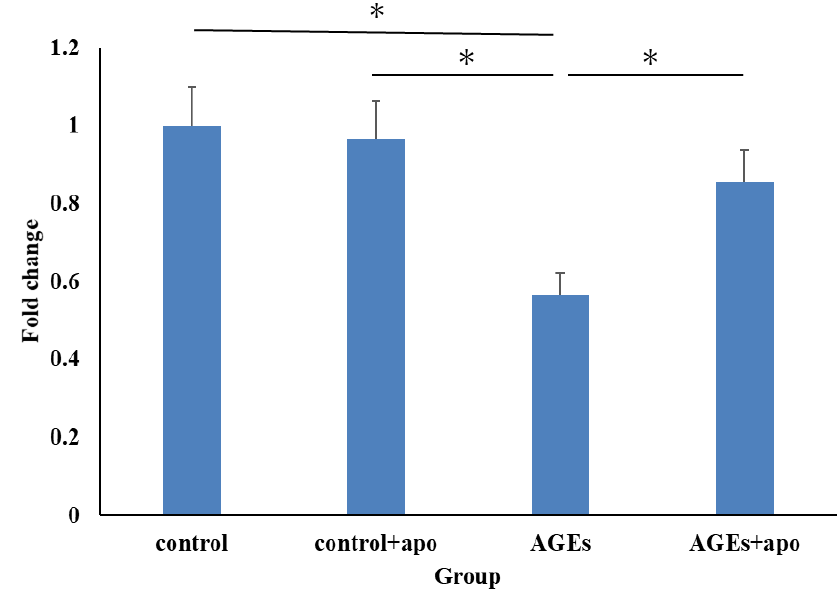
Figure 2. At 48 h, cell viability in the AGEs group was significantly lower than in the control + apo groups. That is, cell viability in the AGEs + apo group was significantly higher than in the AGEs group. However, there was no difference between the control, control + apo, and AGEs + apo groups. * p < 0.05.